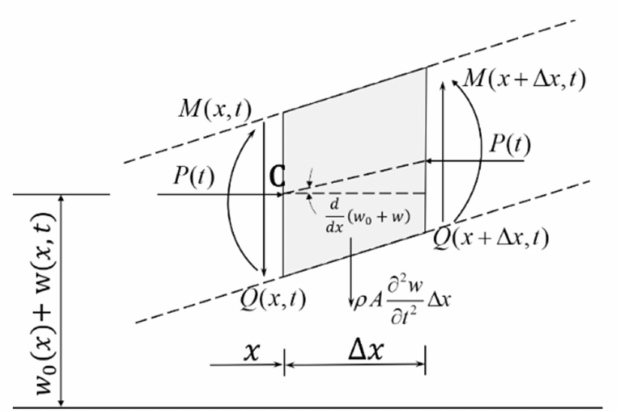
Figure 2. Deformation of a finite beam element in PEH. Based on the classical Euler–Bernoulli beam theory, the shear deformation, and the inertia of the section on the neutral axis are ignored and the transverse deflection w ( x , t ) is considered in the force and moment dynamic equilibrium Equation (1), where Q ( x , t ) is the shear force, ρ is the density of composite beam, A is the cross-sectional area. M ( x , t ) represents the force moment, and P ( t ) is the axial dynamic